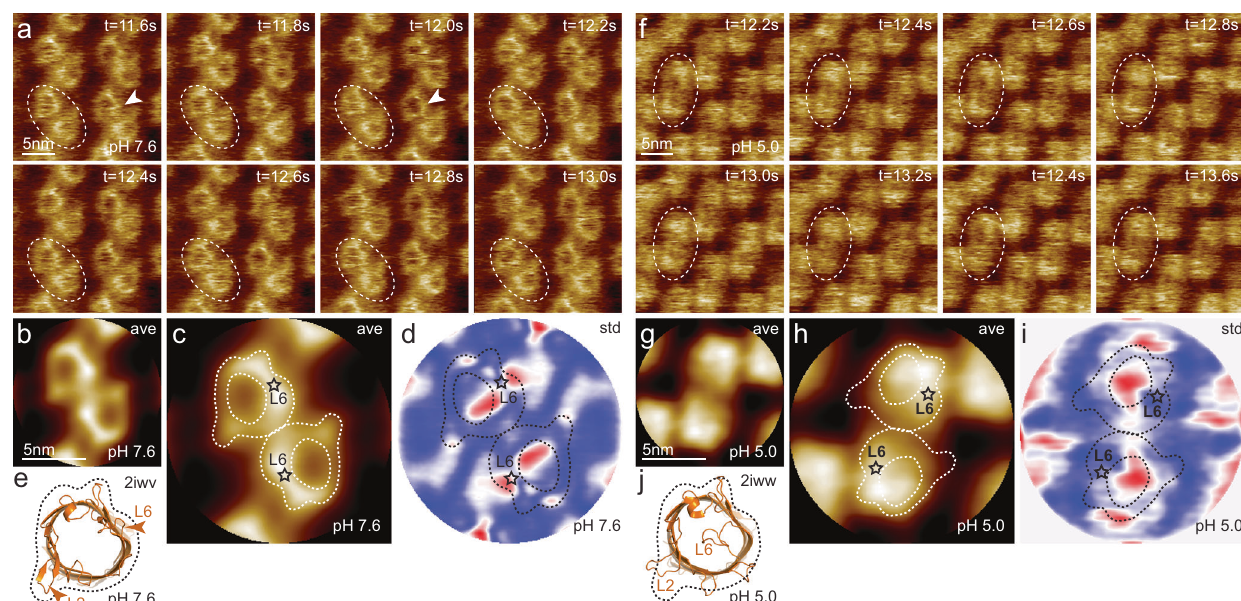
Fig. 1 HS-AFM imaging of OmpG in lipid bilayers at pH 7.6 and pH 5.0. a OmpG at pH 7.6 (Supplementary movie 1, left; frame rate: 200 ms per frame). A OmpG dimer is highlighted with dashed outline in all frames. Arrowheads in t = 11.6 s: Loop-6 fl uctuating over the lumen. Arrowhead in t = 12.0 s: Fully open state. b Correlation average ( n = 2752) of the HS-AFM movie frames (344 frames recorded over 68.8 s, full color scale: 0.0 nm < height < 1.25 nm, where the membrane level was set to 0.0 nm). c Correlation average of OmpG dimers. The topography outline (based on the molecular structure in 1e), serves as a visual guide to locate loop-6 and loop-2 in the topography and is highlighted by the dashed outline (the position of loop-6 is indicated by the asterisk based on its location in the structure ( e )). Inner dashed outline show barrel lumen. d Standard deviation (std) map ( n = 2752) from the averaging process in ( b ) (full color scale from blue to red: 0.05 nm < std < 0.19 nm) and topography outlines as in ( c ). e X-ray structure (PDB 2iwv) of the open OmpG conformation. Loop-6 (arrowhead L6) stands out of the image plane towards the viewer. Loop-2 (L2) forms a beta strand pointing away from the β - barrel, well detected by HS-AFM in the open state ( b ). f OmpG at pH 5.0 (Supplementary movie 1, right; frame rate: 200 ms per frame). A OmpG dimer is highlighted with dashed outline in all frames. g Correlation average ( n = 2472) of the HS-AFM movie frames (309 frames recorded over 61.8 s, full color scale: 0.0 nm < height < 0.7 nm, where the membrane level was set to 0.0 nm). h Correlation average of OmpG dimers. For comparison, the topography outline of the open state ( e ) is shown (the position of loop-6 is indicated by the asterisk). i Standard deviation (std) map ( n = 2472) from the averaging process in ( g ) (full color scale from blue to red: 0.04 nm < std < 0.07 nm) and topography outlines as in ( h ). j X-ray structure (PDB 2iww) of the closed OmpG conformation shown in the same orientation as in ( e ). Loop-6 (L6) folds over the β -barrel lumen in a lid-like manner. Loop-2 (L2) does not form a β - strand in the closed state, in agreement with absence of topography in this region in ( h ). Black dashed line: outline based on ( e ) for